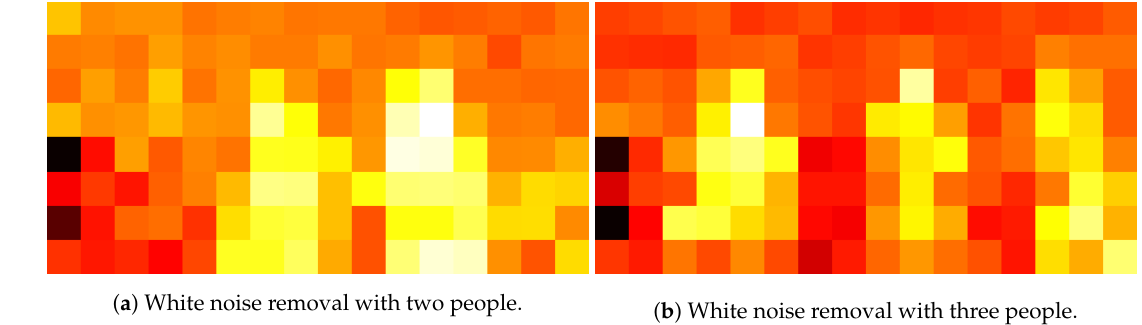
Figure 8. Sample heat maps after white noise